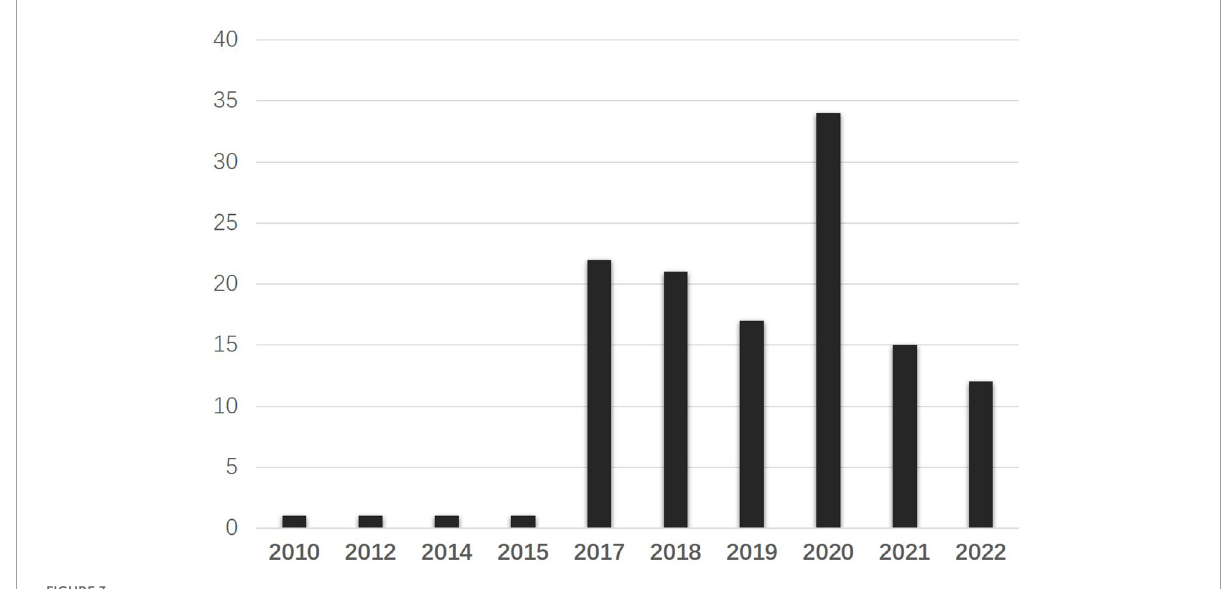
FIGURE3 Frequencies of texts pertaining to Confucius Institutes over time.